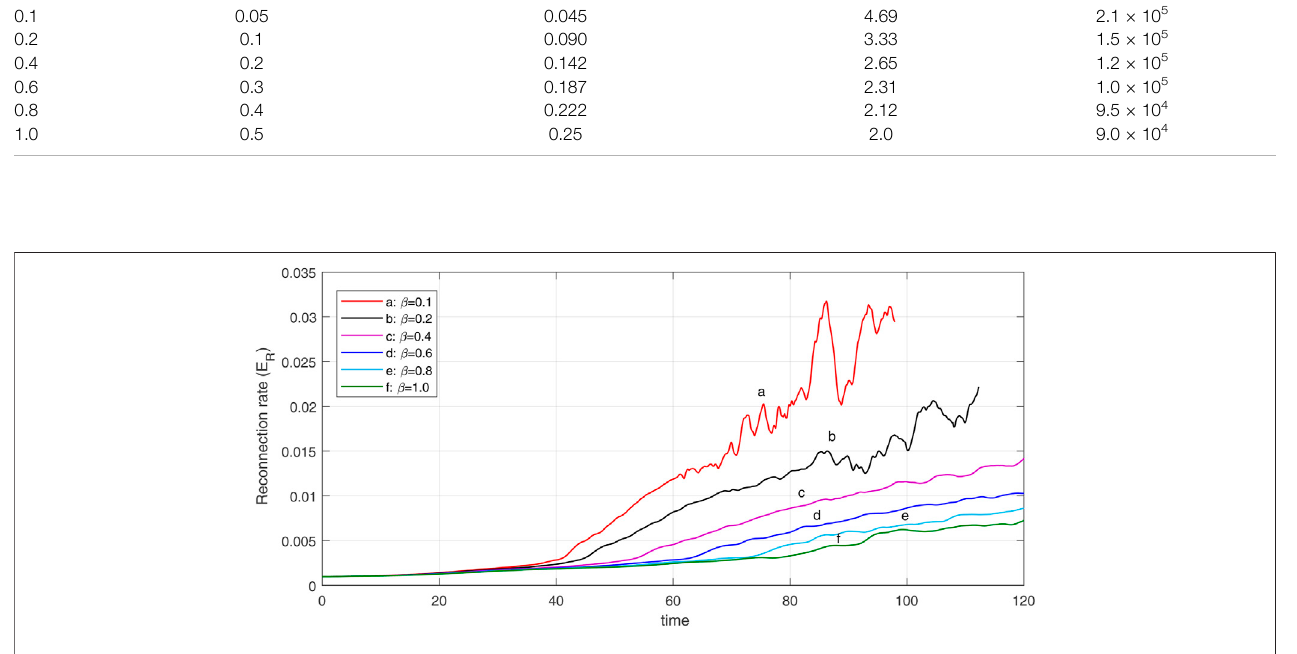
FIGURE 1 | Time variation of magnetic reconnection for different values of β